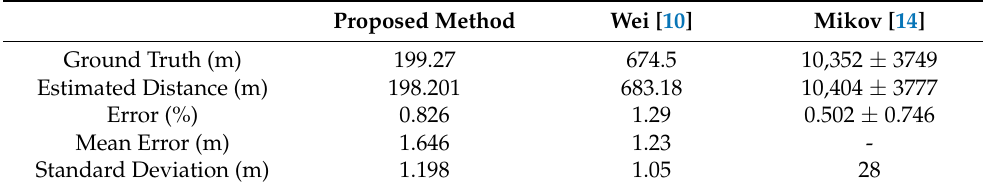
Table 3. Performance Comparison with literature [10,14].